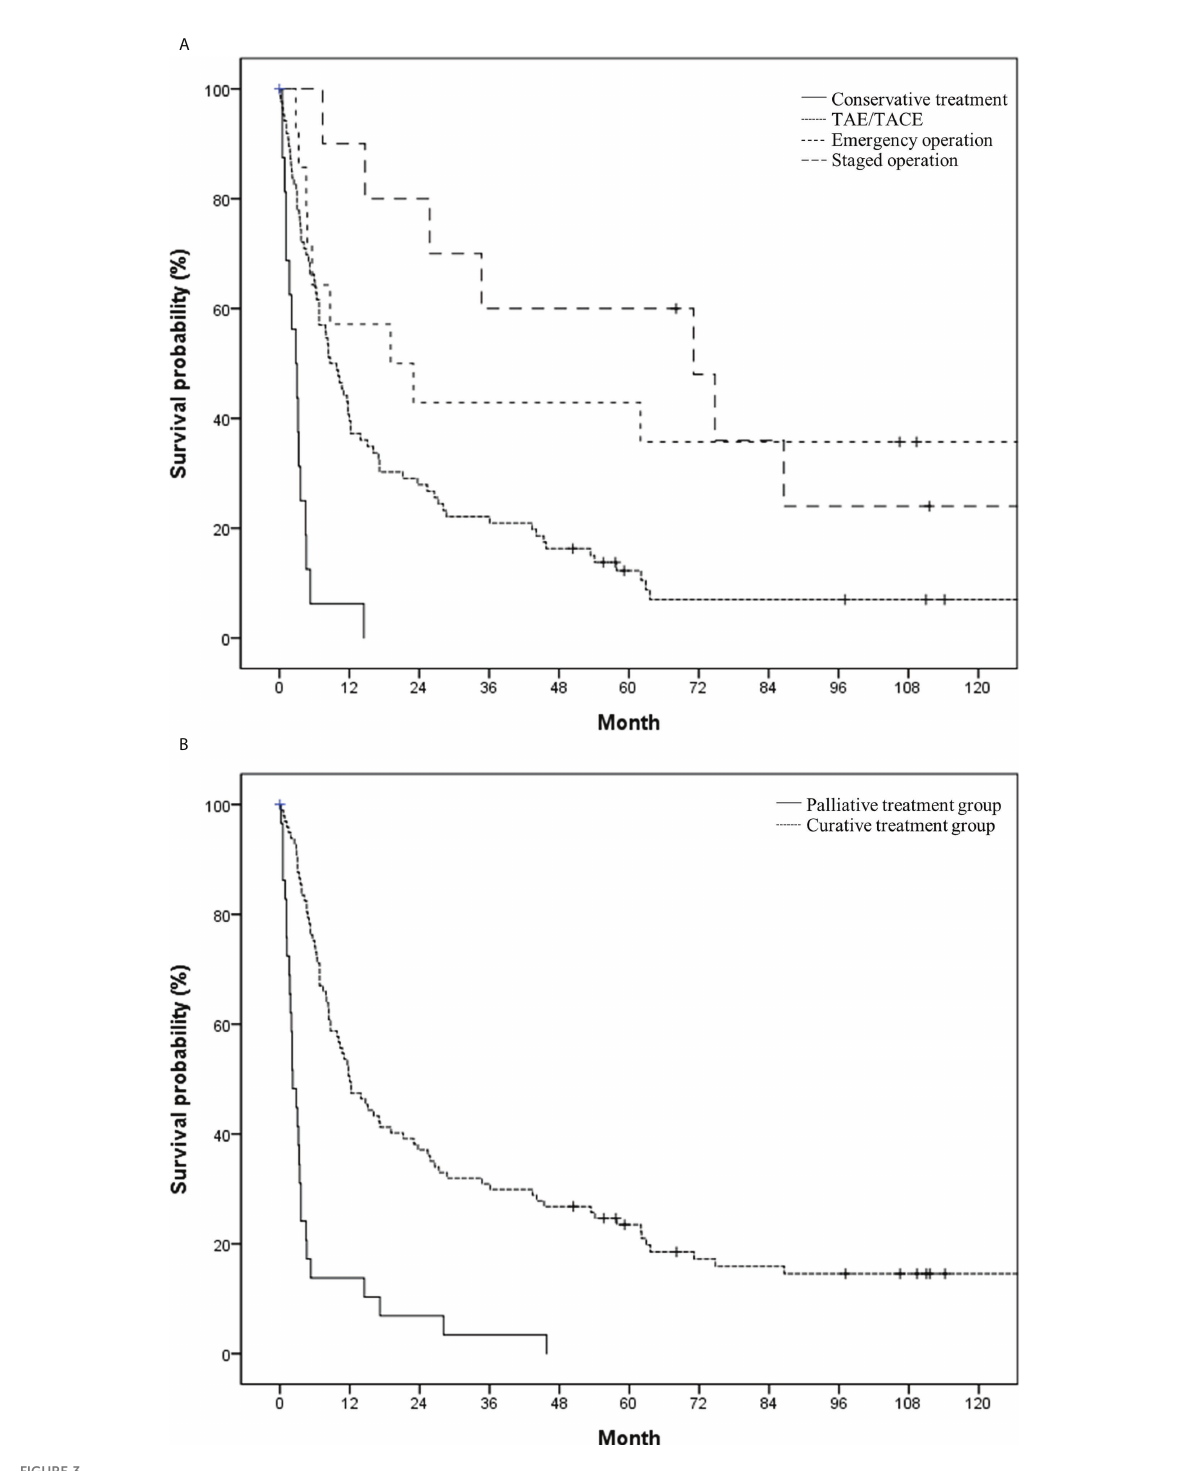
FIGURE 3 Overall survival in the study population based on (A) initial treatment modality (conservative treatment vs. transcatheter arterial (chemo-) embolization vs. emergency operation vs. staged operation) and (B) treatment intent (palliative vs.